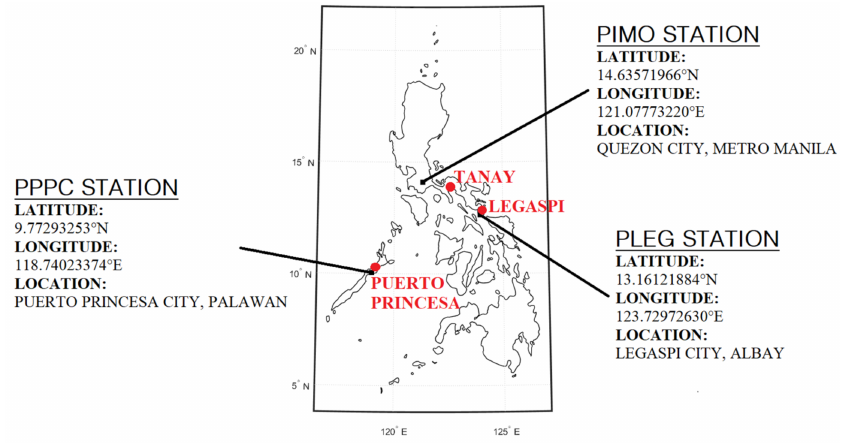
Figure 1. The locations of the GNSS stations (black dots) and their collocated RS stations (red dots) in the Philippines used in this study.